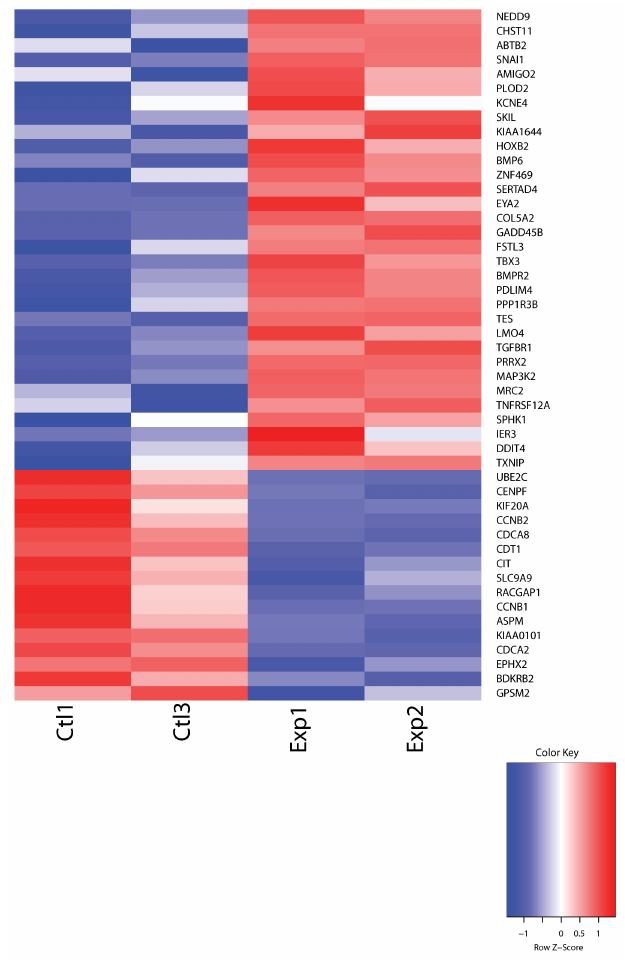
Figure 6. The heatmap of the 48-gene overlap between our study (significant DE mRNAs as determined by DESeq2 (FDR < 0.1)) and the 371 gene signature that differentiates the dSSc and the normal state described by Sargent et al. The red and blue boxes indicate relative over- and under-expression with respect to a reference which is calculated as the mid-point between the control and TGF β treated